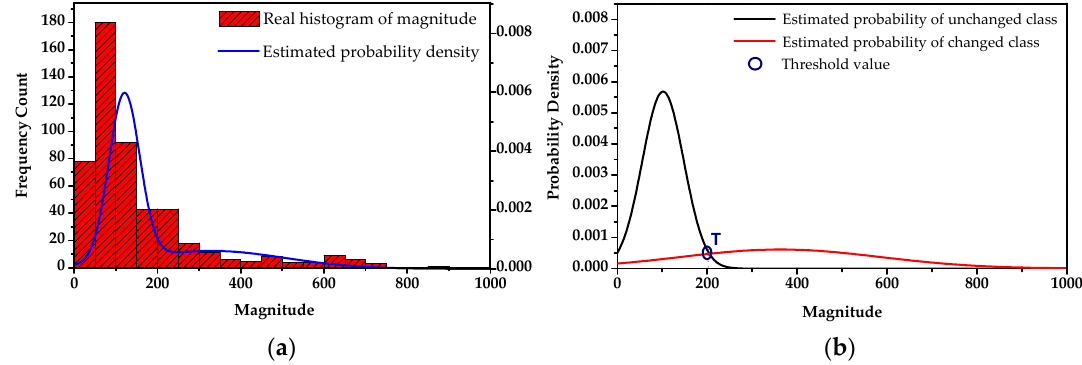
Figure 9. ( a ) The real histogram of magnitude (red bars) and estimated probability density curve (blue line) by the EM algorithm under Gaussian assumption; ( b ) The curves of estimated probability of unchanged (black line) and changed (red line) classes, and the estimated threshold value (blue point) to separate these two classes.